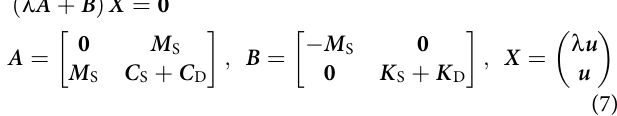
FIGURE 15 | Mass and story stiffness of 20-, 30-, and 40-story shear buildings . (A) Mass (tons) and (B) story stiffness (kilonewtons per